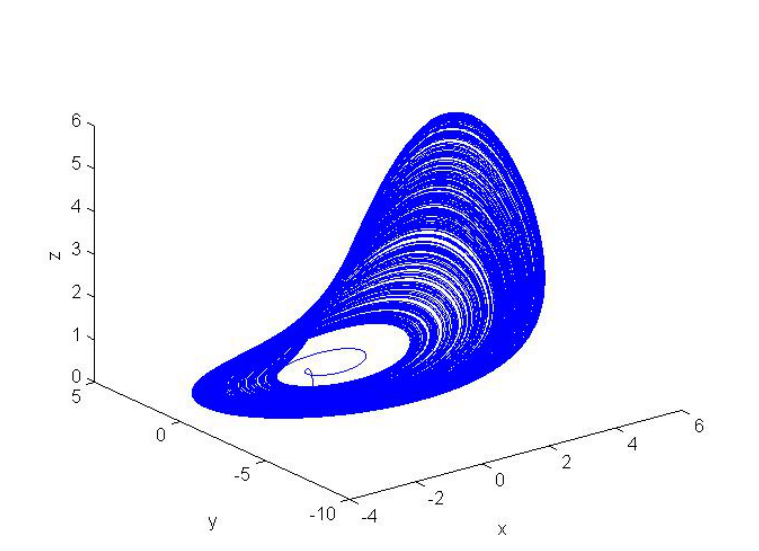
Figure 2. Rössler attractor.